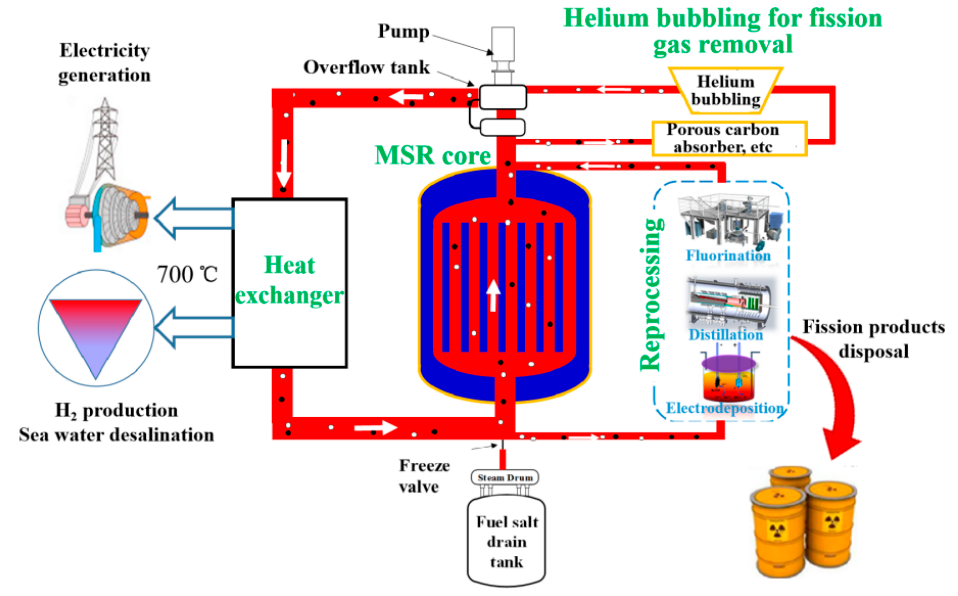
Figure 2. Overview of a molten salt reactor system.